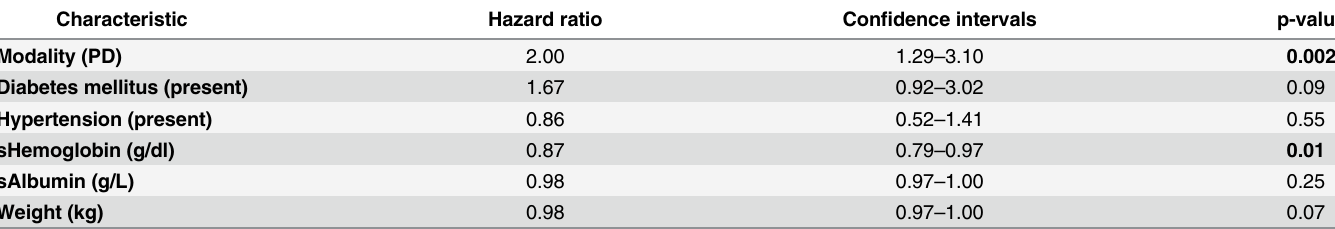
Table 4. Multivariate Cox regression model of the baseline predictors of all-cause mortality.